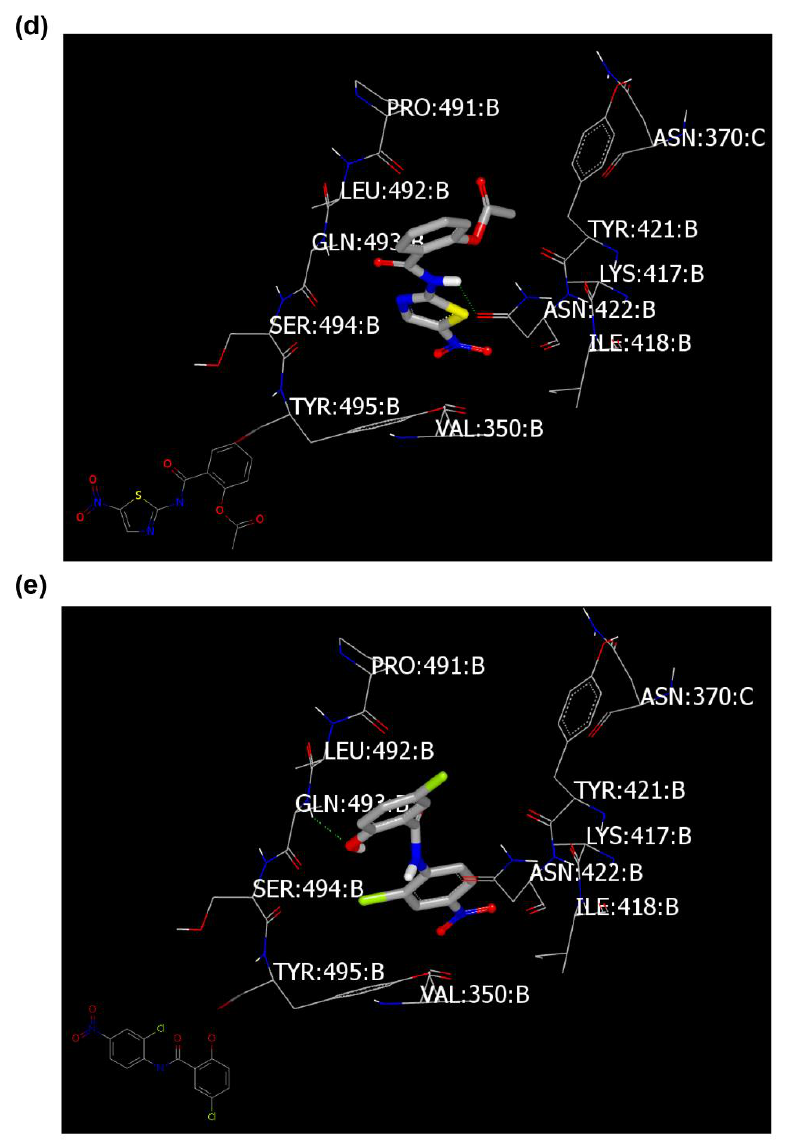
Figure 4. Visual representation by VIDA for docking with spike glycoprotein (PDB ID: 6vsb). ( a ) Standard ligand docked inside the receptor (HB in green color), ( b ) ligand inside the inner grid for validation, ( c ) Azithromycin docked peripherally, ( d ) Nitazoxanide docked with formation of weak HB (green color), and ( e ) Niclosamide docked with formation of strong HB (green color).